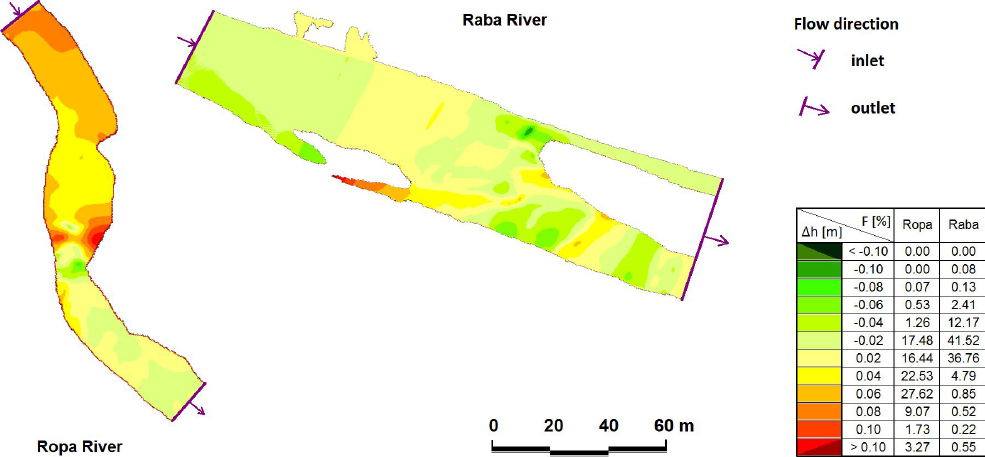
Figure 2. Comparison of calculated and measured water surface levels: the Ropa River for discharge of 6.71m 3 s − 1 and the Raba River for discharge of 10.29m 3 s − 1 ( (cid:49)h – difference between measured and calculated water surface level, F – area of particular differences, percentage).